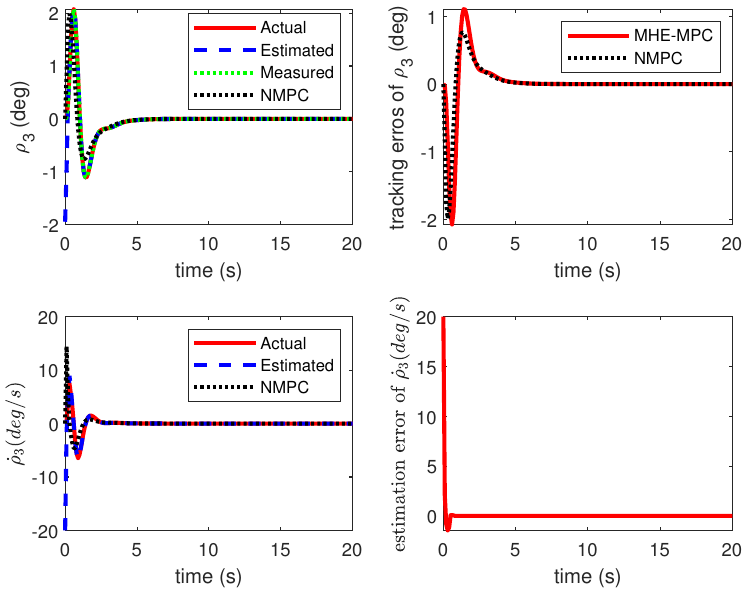
Figure 6. Case 1: state variables ρ 3 , ˙ ρ 3 and their tracking/estimation